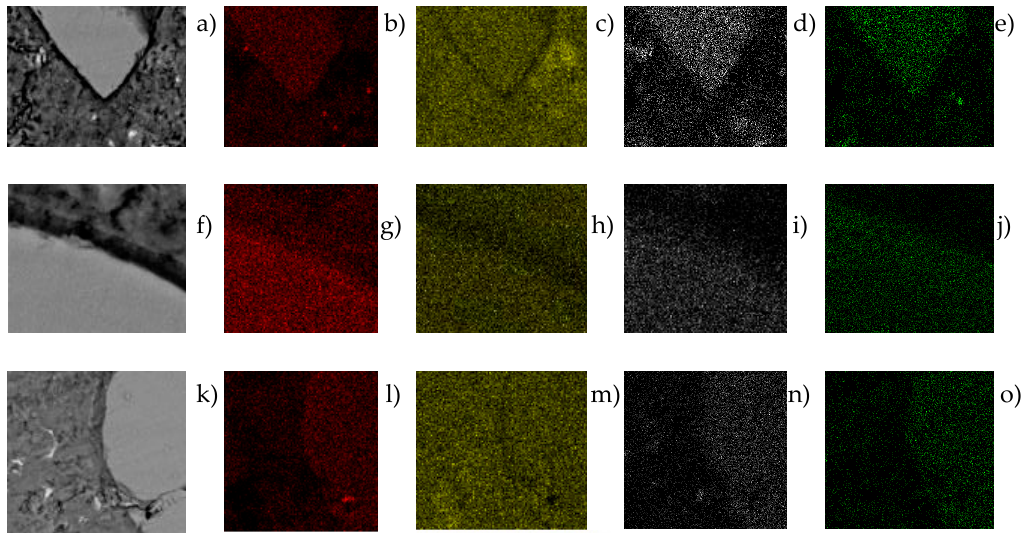
Figure 8. ( a ) SEM image at 28 days at 1300 × ; maps of electrons of Si ( b ), Ca ( c ), Al ( d ) and Mg ( e ); ( f ) SEM image at 28 days at 5000 × ; maps of electrons of Si ( g ), Ca ( h ), Al ( i ) and Mg ( j ); ( k ) SEM image at 120 days at 1300 × ; maps of electrons of Si ( l ), Ca ( m ), Al ( n ) and Mg ( o ).